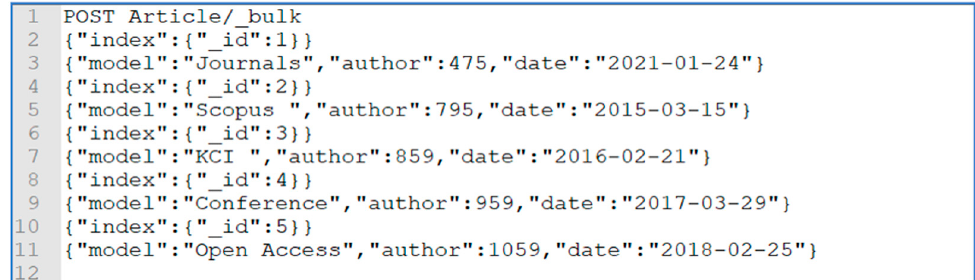
Figure 1. Primary shard structure.